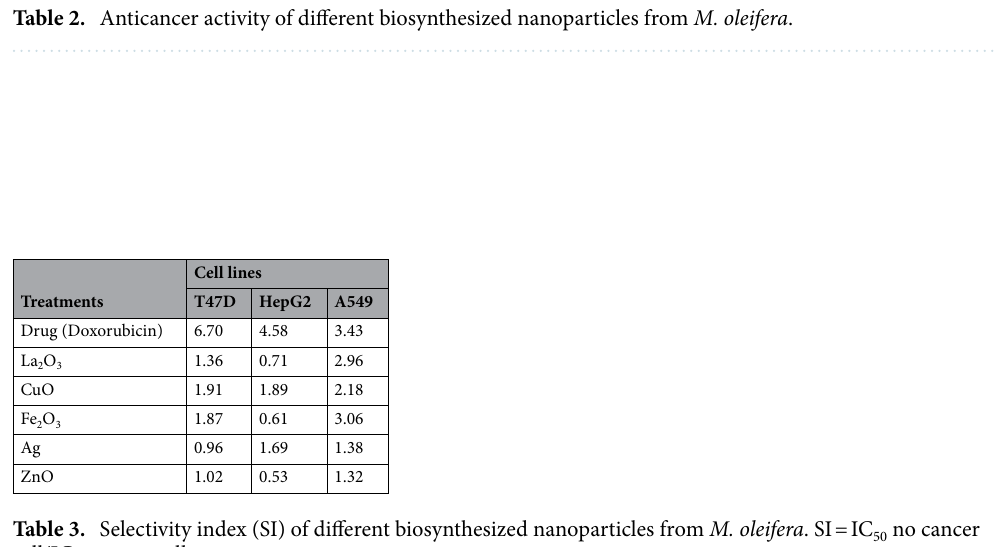
Table 3. Selectivity index (SI) of different biosynthesized nanoparticles from M. oleifera . SI = IC 50 no cancer cell/IC 50 cancer